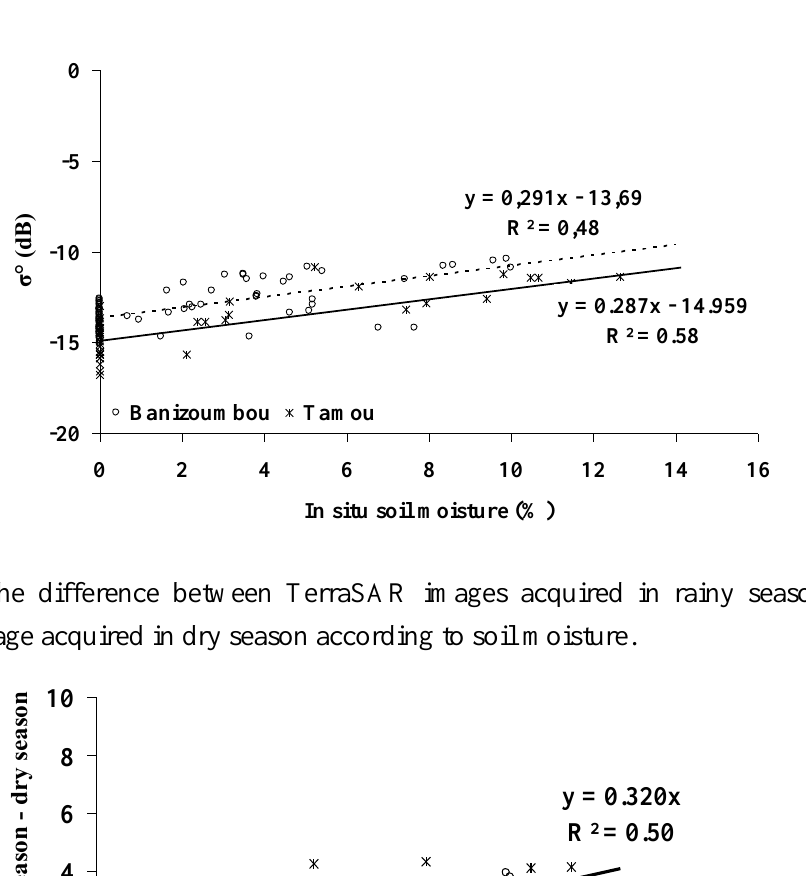
Figure 6. Sensitivity of TerraSAR-X signal to surface soil moisture for each study site (27° for Banizoumbou and 39° for Tamou). Each point corresponds to the average backscattering coefficient in decibels of pixels around in situ measurements of soil moisture.